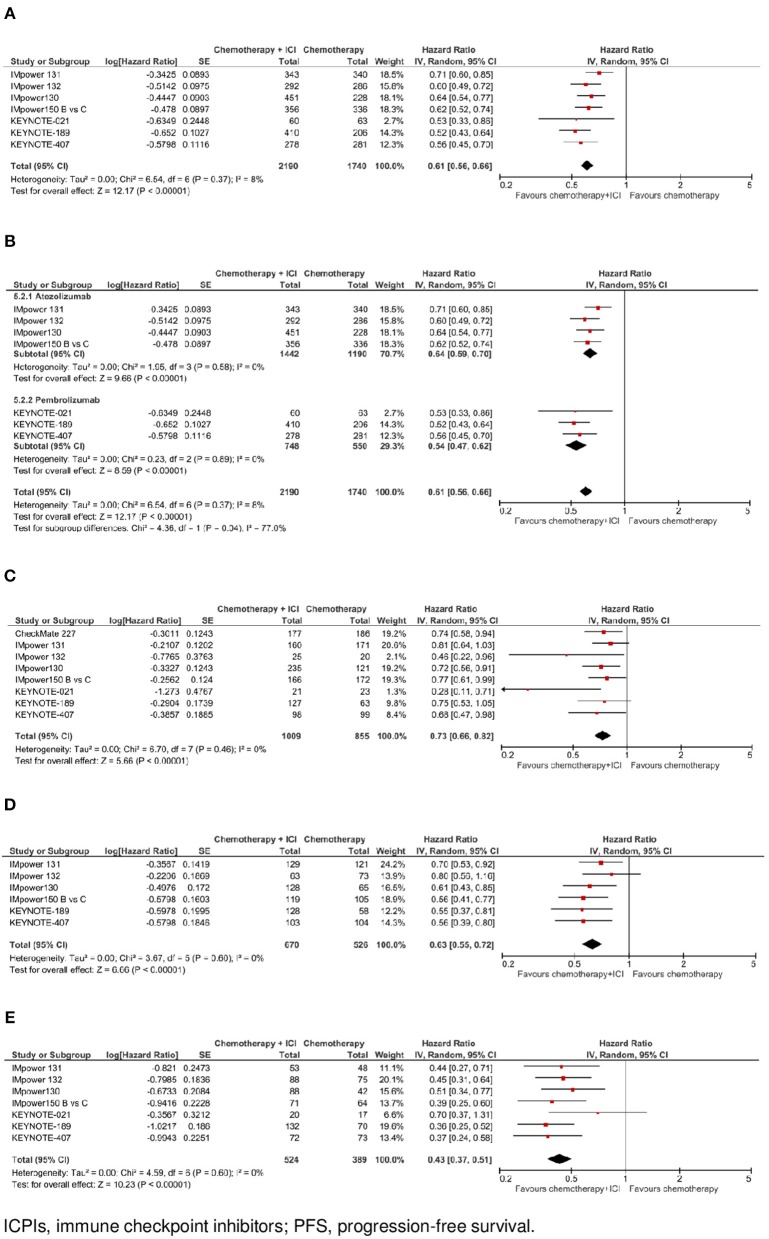
Progression-free survival with chemotherapy plus ICPI. (A) PFS in whole study population. (B) PFS by ICPI administered. (C) PFS by PD-L1 expression- PD-L1 negative. (D) PFS by PD-L1 expression - PD-L1 low. (E) PFS by PD-L1 expression- PD-L1 high.